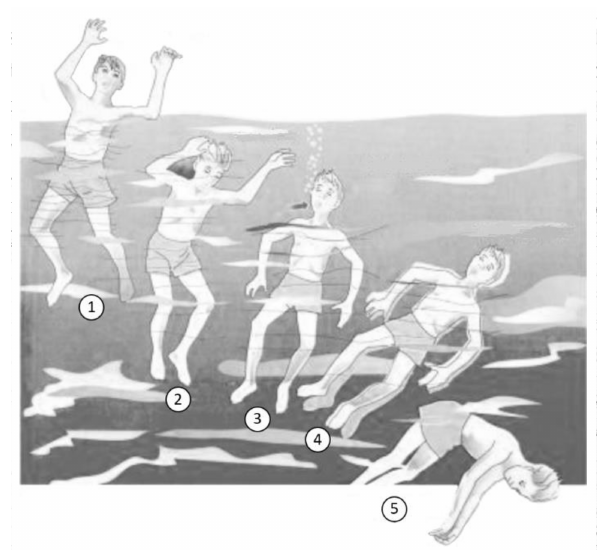
Figure 1. The five subsequent phases of the drowning process. 1: Agitation and request for help. 2: Apnoea, 3: Deep breathing. 4: Asphyxia convulsions. 5: Definitive